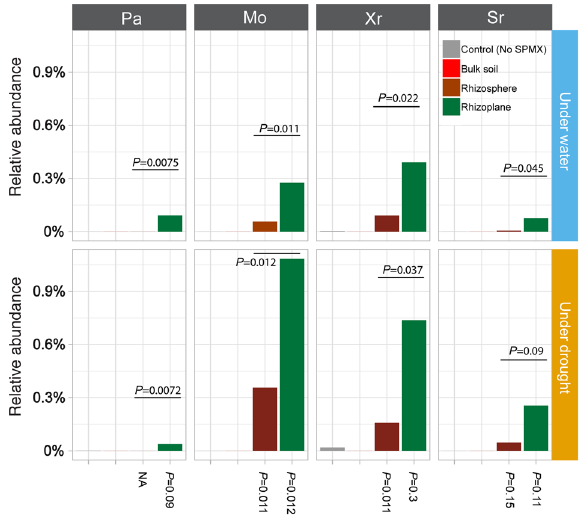
Fig. 4 The relative abundance of four individual strains in the root-associated microbiome. The relative abundance of each strain colonized in the bulk soil (red), rhizosphere (dark red) and rhizoplane (dark green) of SPMX-inoculated plants at 21 dpi under either regular water conditions (upper bar chart), or drought conditions (lower bar chart). The relative abundance of each strain in the control (gray) presents a sum of their abundance in the rhizosphere and rhizoplane of non-SPMX inoculated control plants, respectively. FDR adjusted P values generated by Wilcoxon rank-sum test presented above and below bar chart indicate statistical signi fi cance in relative abundance of individual strains between rhizosphere and rhizoplane (above), and between under water and drought conditions (below), respectively. Data based on fi ve samples ( n = 5) collected in each treated